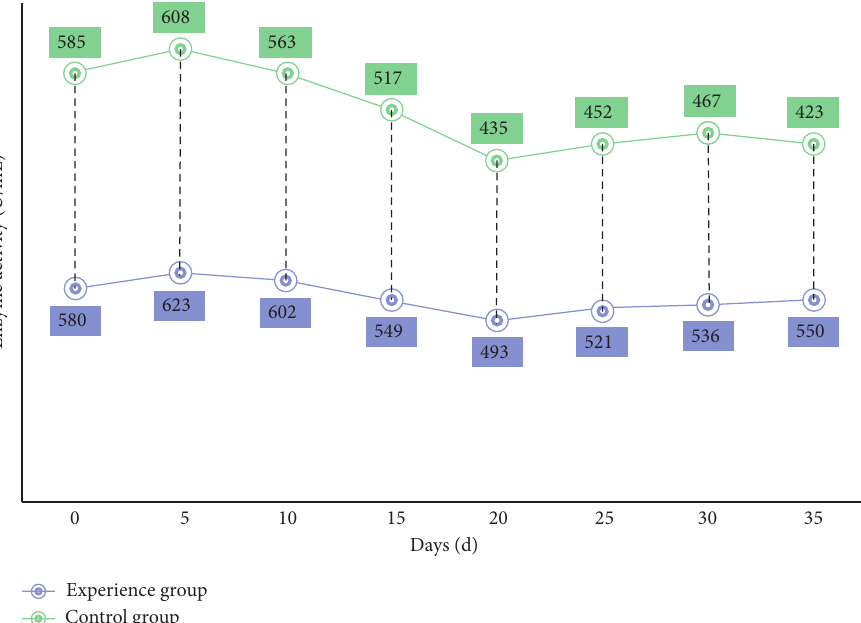
Figure 4: Statistical analysis of the preservation stability of nanoparticles in each group of experimental